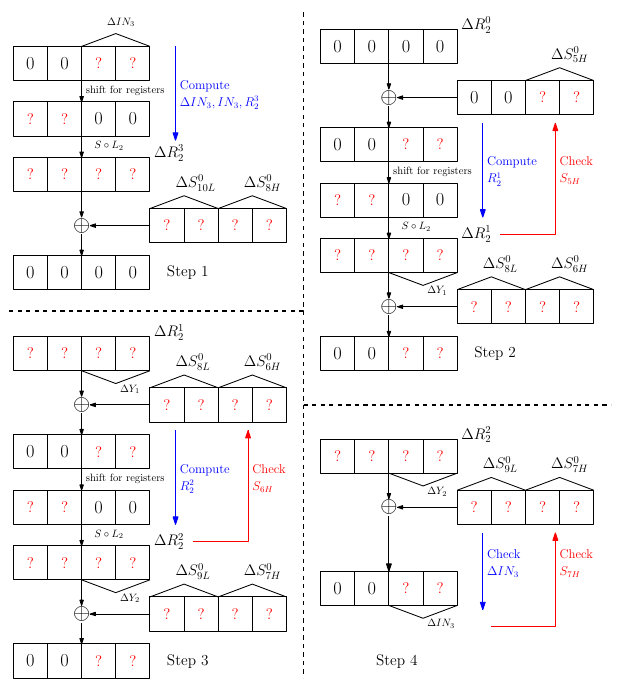
Figure 5: The procedure to find valid difference transitions and value transitions in FSM for the first 4